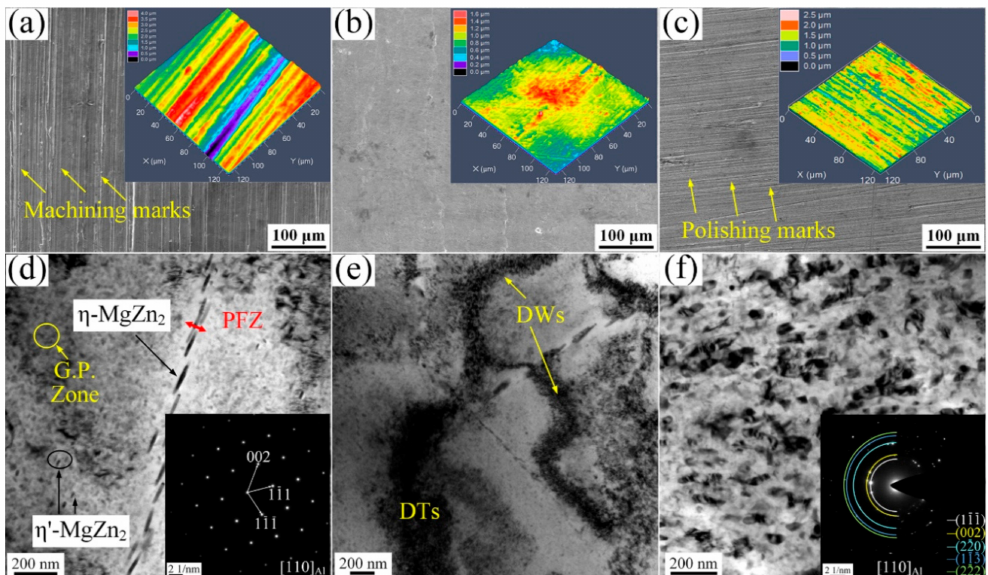
Figure 2. Surface SEM secondary electron images of di ff erent samples: ( a ) untreated sample (BM), ( b ) one-pass USRP treatment (UR1), and ( c ) 12-pass USRP treatment (UR12-P). Insets display the corresponding CLSM images. TEM images showing the microstructure in the surface of ( d ) BM, ( e ) UR1, and ( f ) UR12-P. Insets show the corresponding SAED